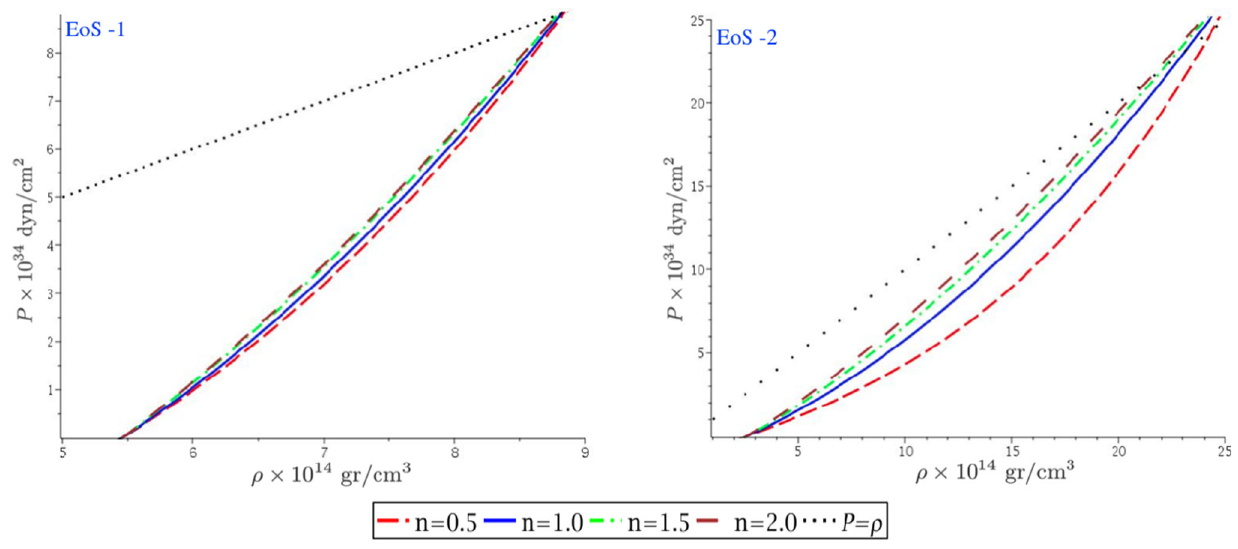
Fig. 3 The radial pressure, P , as a function of energy density, ρ , for different values of the polytropic index n corresponding to an object of radius r b = 10 Km and σ = 0 . 12. The displayed profiles utilize the parameters listed in Table 1, and the dotted line represents the EoS